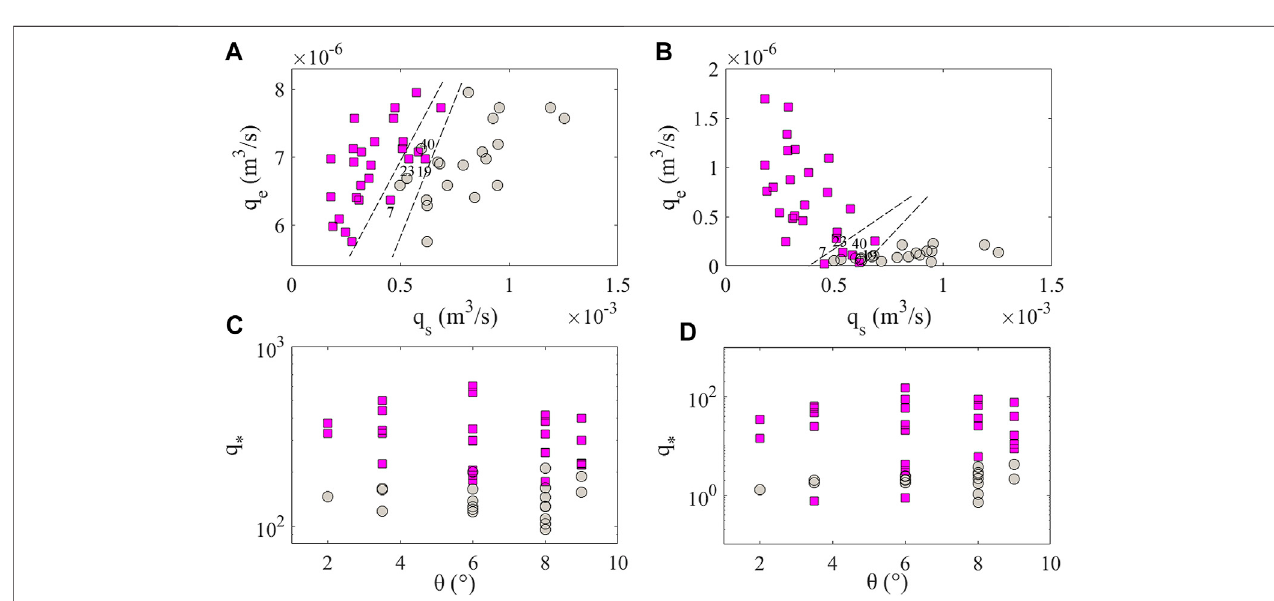
FIGURE 2 | Relationship between depositional capacity of landslides q s and erosive capacity of river fl ows q e obtained from Chen et al. (2019a) (A) and numerical simulation (B) ; critical threshold of dimensionless discharge q * derived from Chen et al. (2019a) (C) and experimental simulations (D) as a function of river slope θ . Red squares represent the experimental runs with no dam, and gray dots represent the experimental runs with dams. The values of these variables are obtained as an average from the time that the landslide starts entering the river until the time that the landslide dam forms.